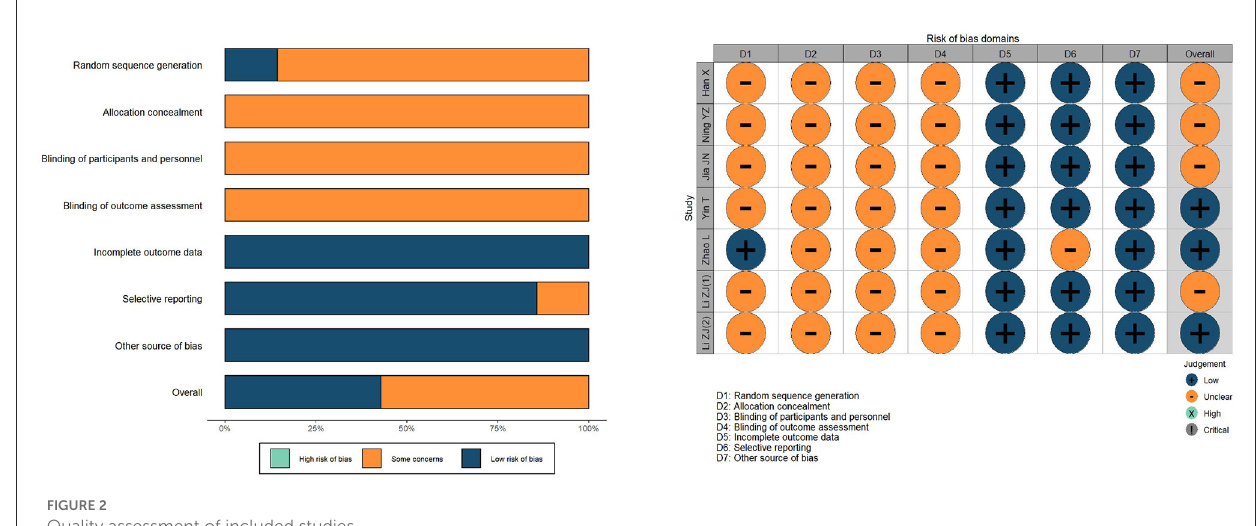
FIGURE2 Quality assessment of included studies.